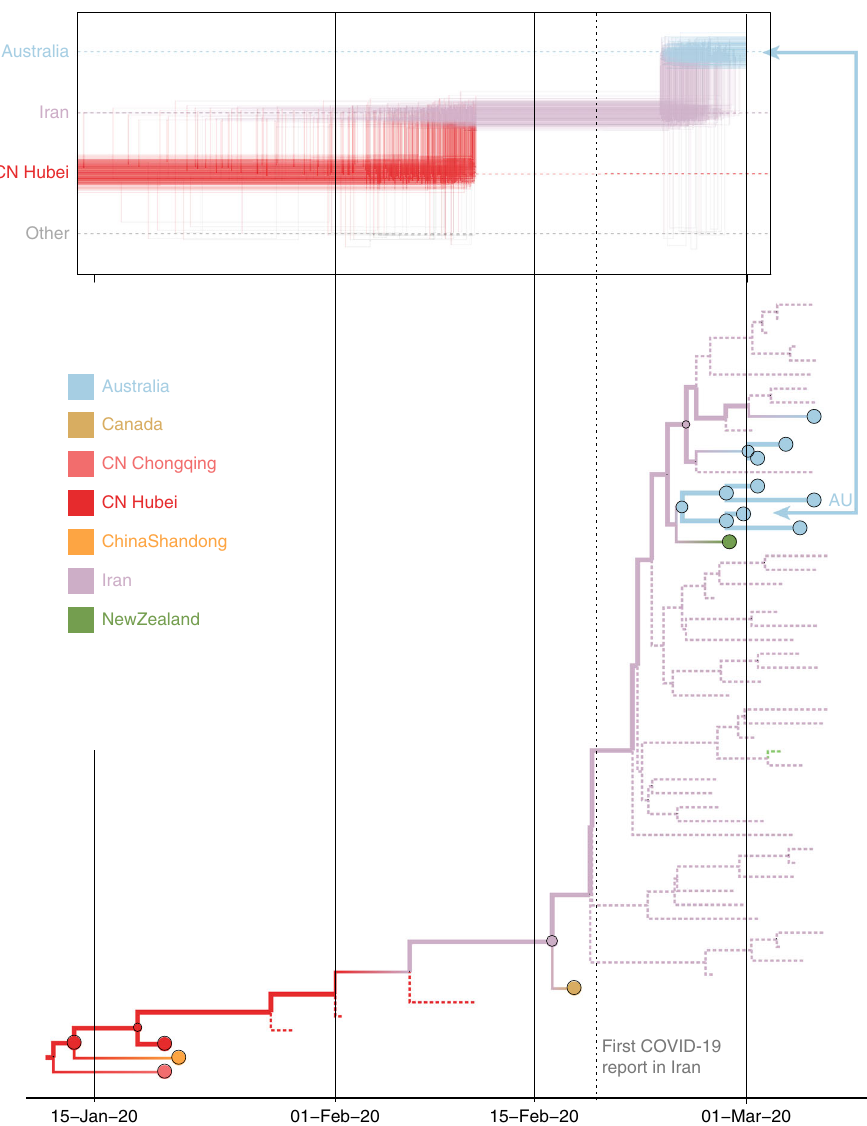
Fig. 5 Markov jump trajectory plot as in fi g. 3 for the Australian genome (EPI_ISL_412975) in lineage B.4 and B4 subtree for the Bayesian phylogeographic analysis incorporating travel data and unsampled diversity. Dotted branches in the phylogeny are associated with unsampled taxa assigned to Iran and Hubei, China. The tip for the Australian genome corresponding to the trajectory is indicated with an arrow. The vertical dotted line represents the fi rst report of COVID-19 in